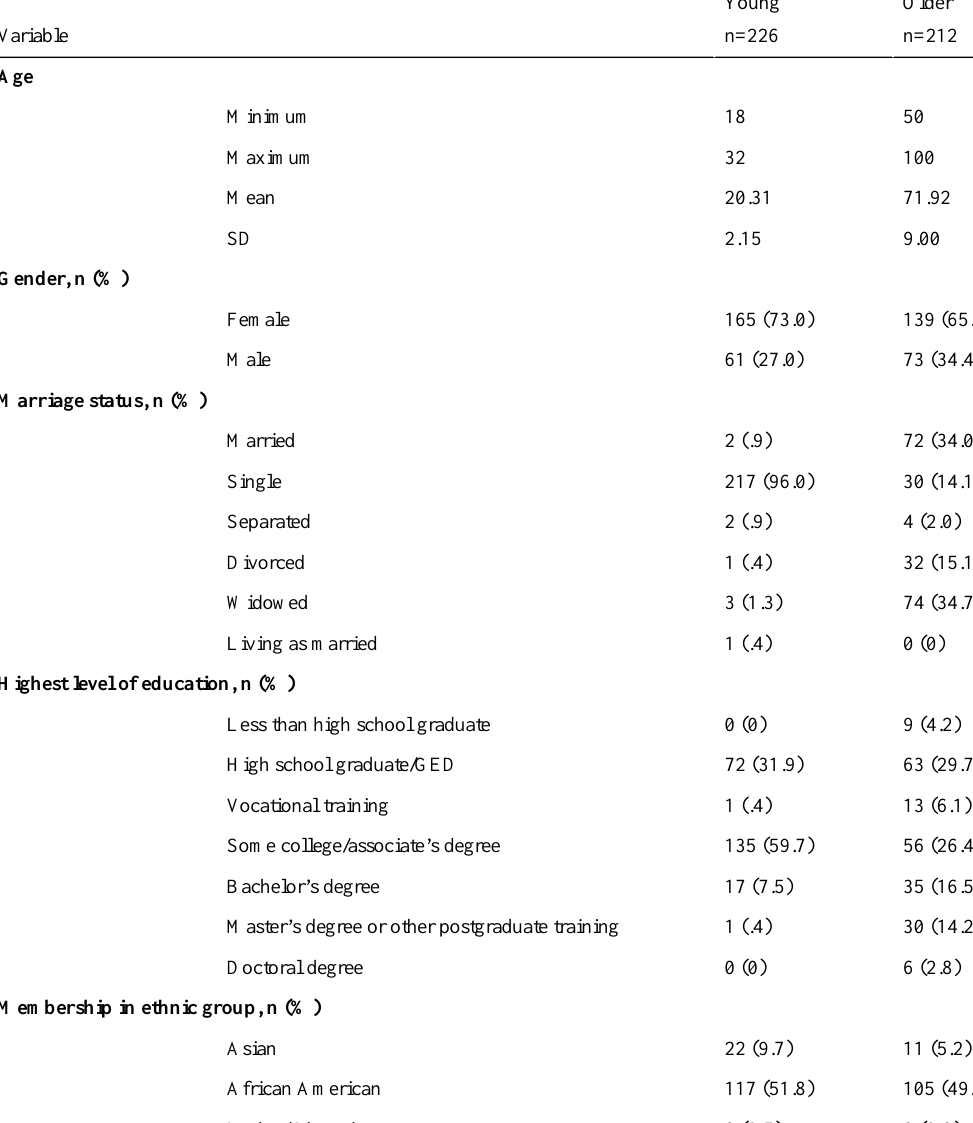
Table 1. Demographic characteristics of study